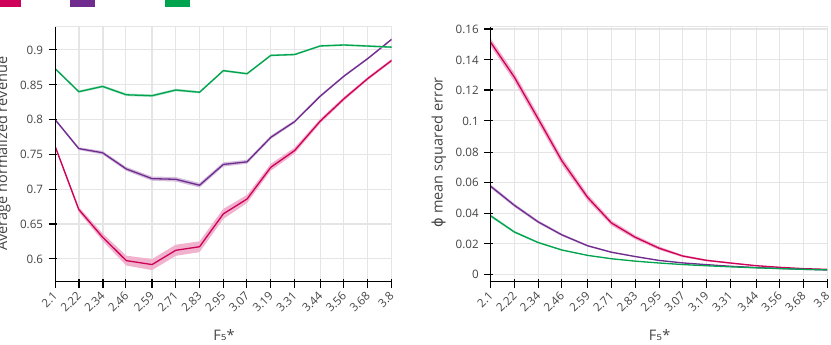
Figure 7. The comparison between the average performance of the revenue management system (RMS), the heuristic method from [33] and reinforcement learning (RL) (99% confidence level). The system’s performance is better the higher the average normalized revenue is (the best theoretical response that requires the perfect knowledge of the demand parameters of all time steps is normalized to be one). On the right chart, we show the estimation mean squared error of demand model, which indicates that smaller errors are